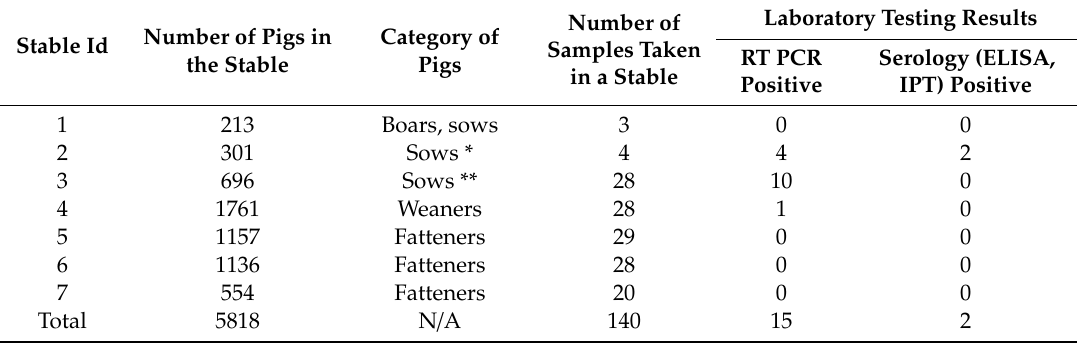
Table 2. RT PCR and serology results of pigs of Farm A sampled in di ff erent stables before culling.